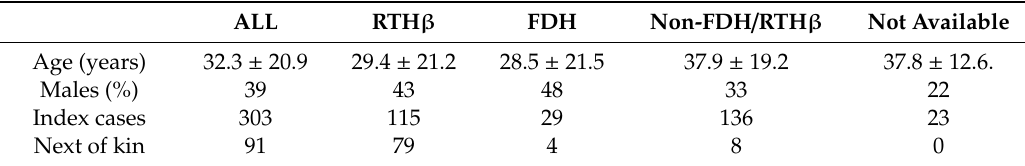
Table 1. Age, sex, number of families / isolated cases of patients with suspected thyroid hormone (RTH)